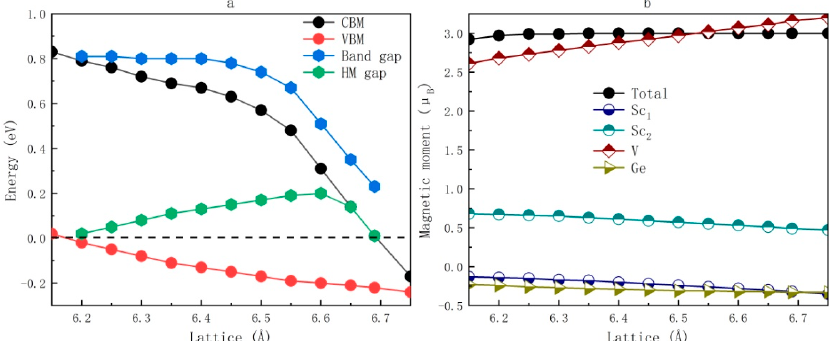
Figure 6. (a) band minimum (CBM), valence band maximum (VBM), Band gaps, and half-metal (HM) gaps of the spin-up channel bands as a function of lattice parameter, and ( b ) the total and atomic magnetic moments as a function of lattice parameter for XA-type Sc 2 VGe.